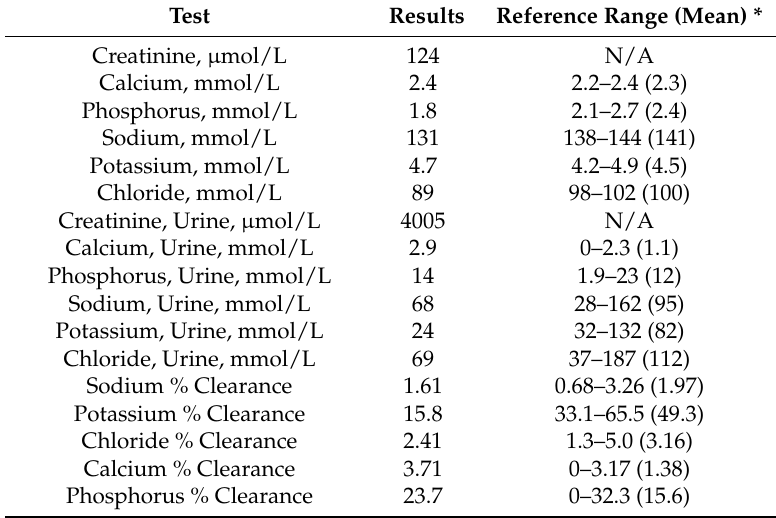
Table 2. Urine electrolyte clearance study performed to rule out underlying glomerular